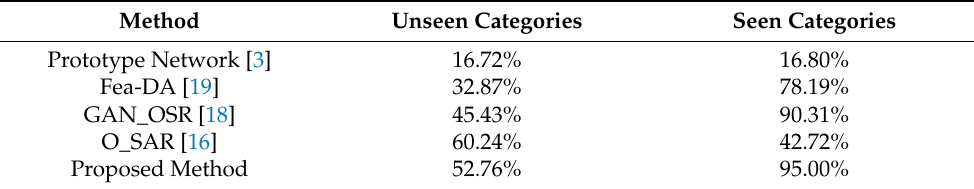
Table 2. Recognition accuracies for unseen categories and seen categories with different methods in the five-types classification problem (K = 20).